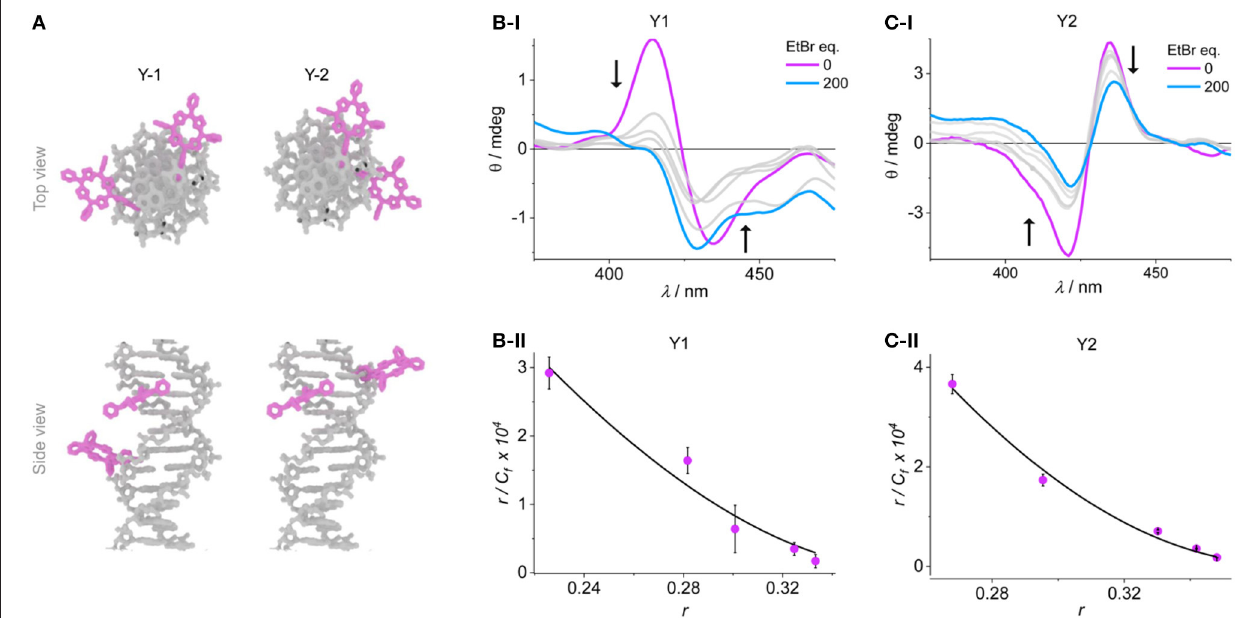
FIGURE 4 | (A) Representation of the duplexes Y1 and Y2 . Example CD spectra of the titration experiments of (B-i) Y1 and (C-i) Y2 , the arrows indicate the peak shift upon addition of EtBr. Scatchard plots are shown in (B-ii) and (C-ii) , respectively, together with the fitted curves according to Equation (1).